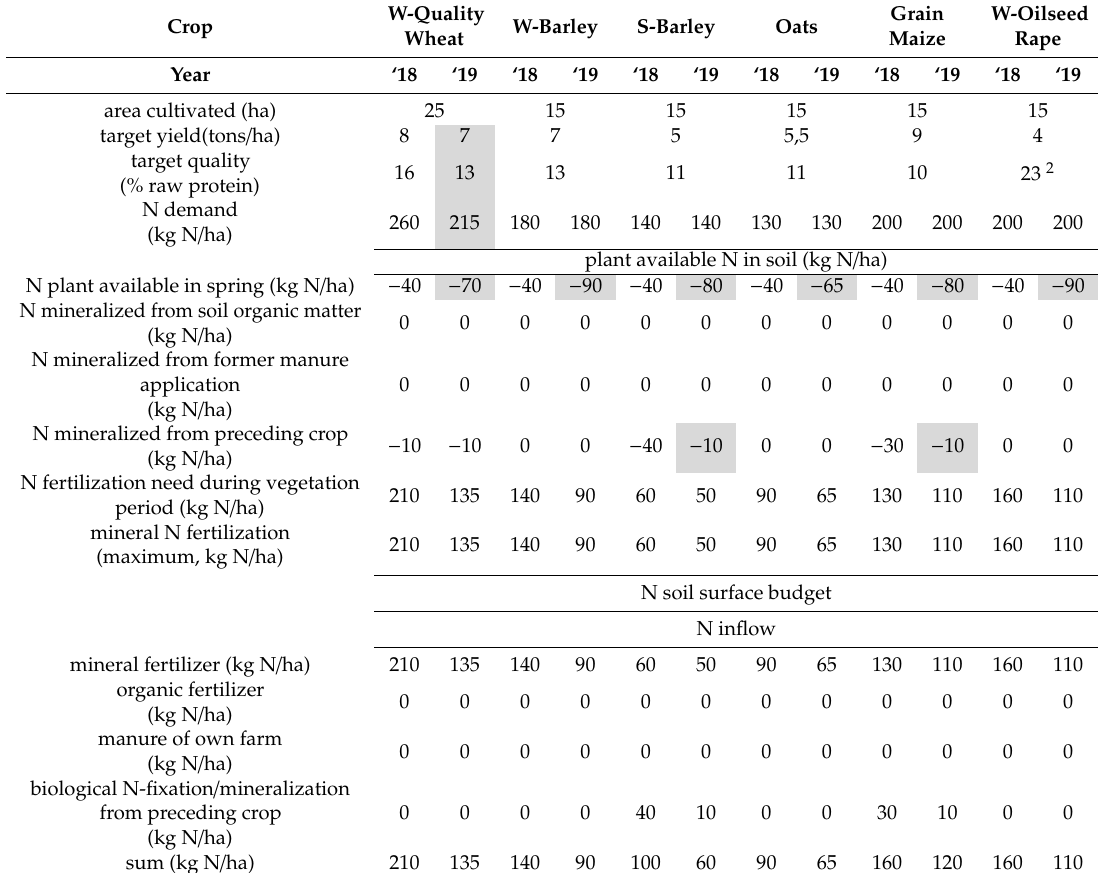
Table 3. Soil surface budget of a fictive arable 100 ha model farm in the dry year 2018 and the year 2019, set up according to